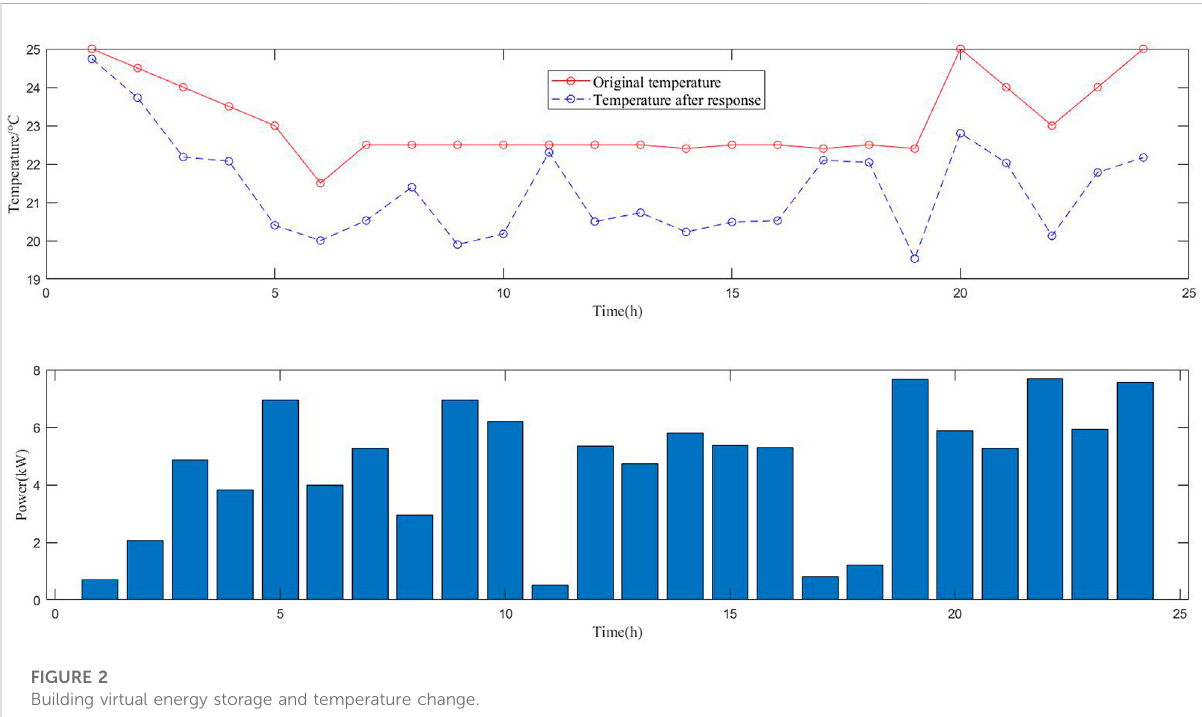
FIGURE 2 Building virtual energy storage and temperature change.